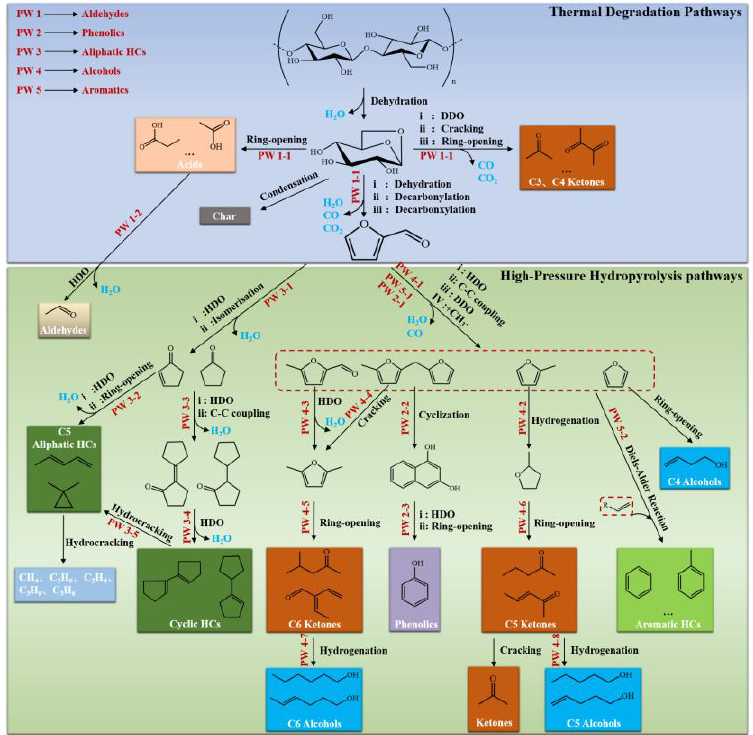
Figure 7. Possible reaction mechanisms involved in the formation of various products during the fast pyrolysis of cellulose [86].